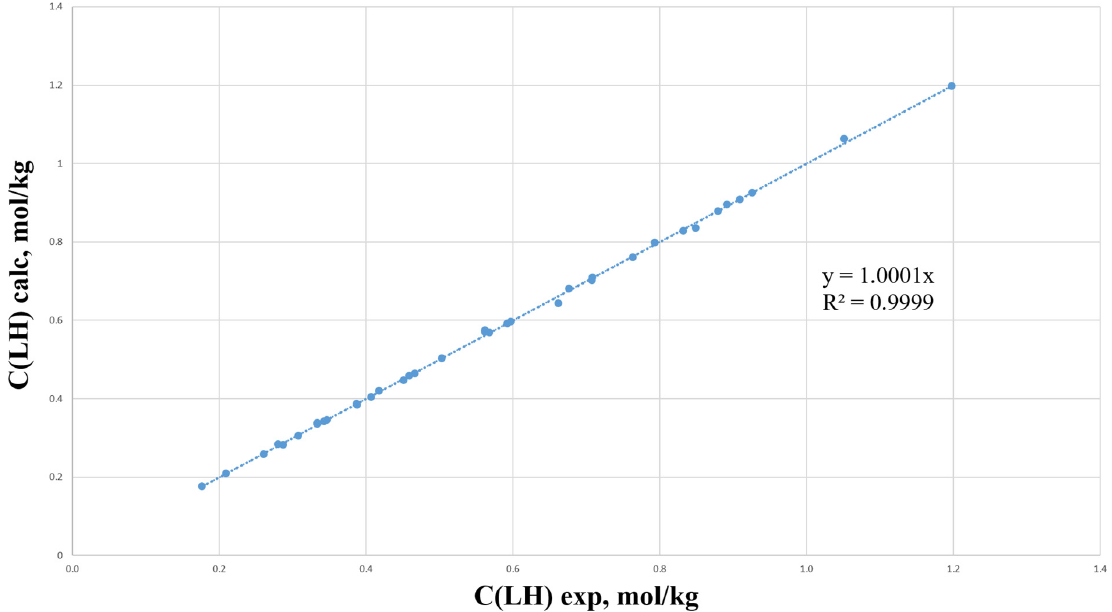
Figure 3. Material balance data of the esterification series: – Δ C(LH) is the absolute decline in lactic acid concentration, and Δ C(BL) is the increment in butyl lactate concentration. The obtained kinetic data for the esterification of lactic acid with n -butanol were pro- cessed by numerical integration of Equations (6) and (7) using the least squares method. The minimum sum of squared deviations between the calculated and experimental con- centrations of lactic acid, ammonium lactate, lactamide, and butyl lactate was α ≈ 1. The results were consistent with the general acid catalysis model of the esterification reaction (2) and the experimental data (Figure 4).